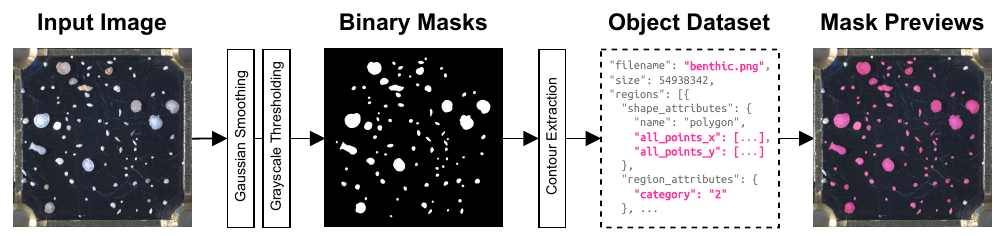
Figure 3. High-level summary of the dataset creation